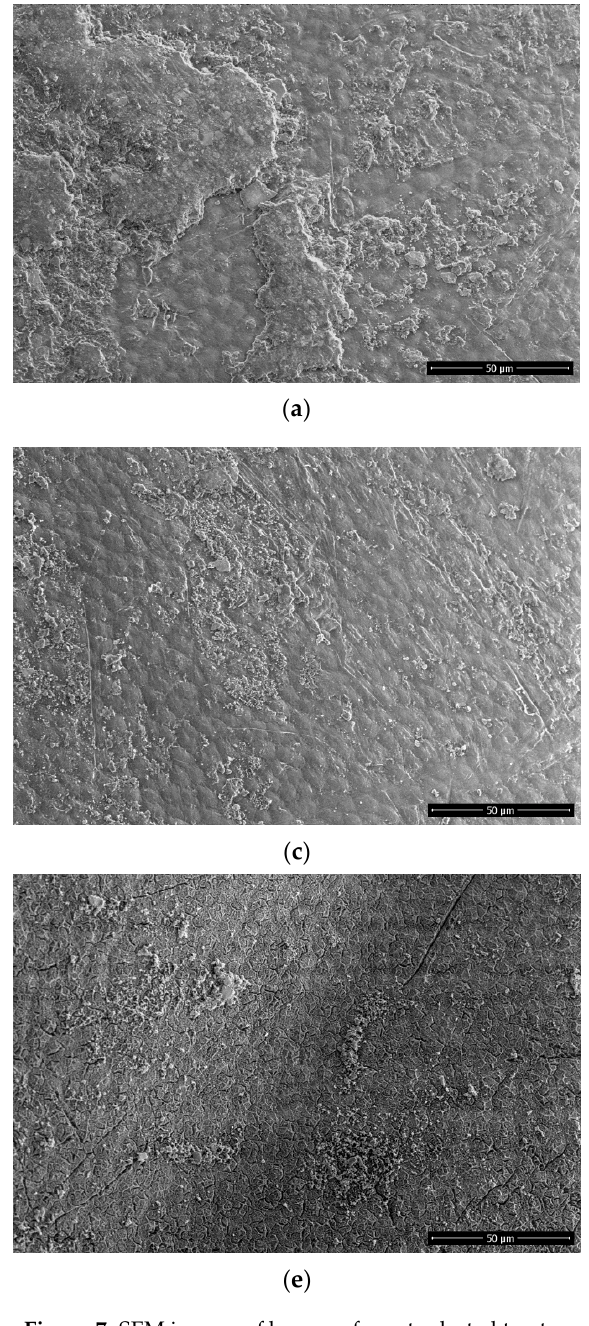
Figure 7. SEM images of bean surface at selected treatment conditions: ( a , b ) untreated; ( c , d ) p = 5 Pa, t = 3 s; ( e , f ) p = 20 Pa, t = 3 s. ( a , c , e ) 2000× magnification; ( b , d , f ) 10,000× magnification.